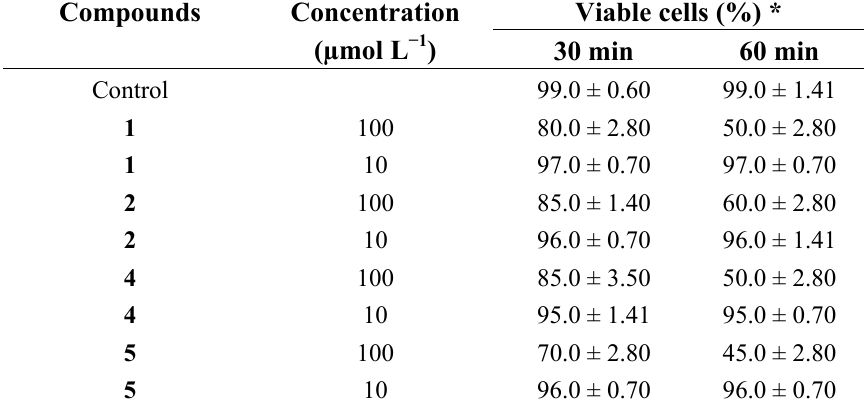
Table 2. Evaluation of the cytotoxicity of compounds 1 , 2 , 4 and 5 at different times and